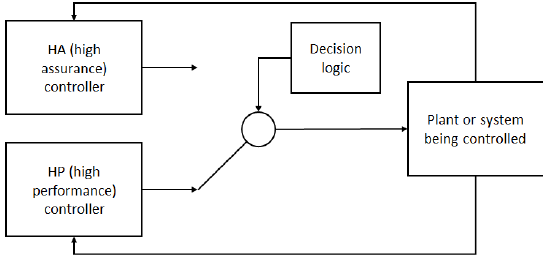
Figure 1. The original simplex architecture (SA) [3].